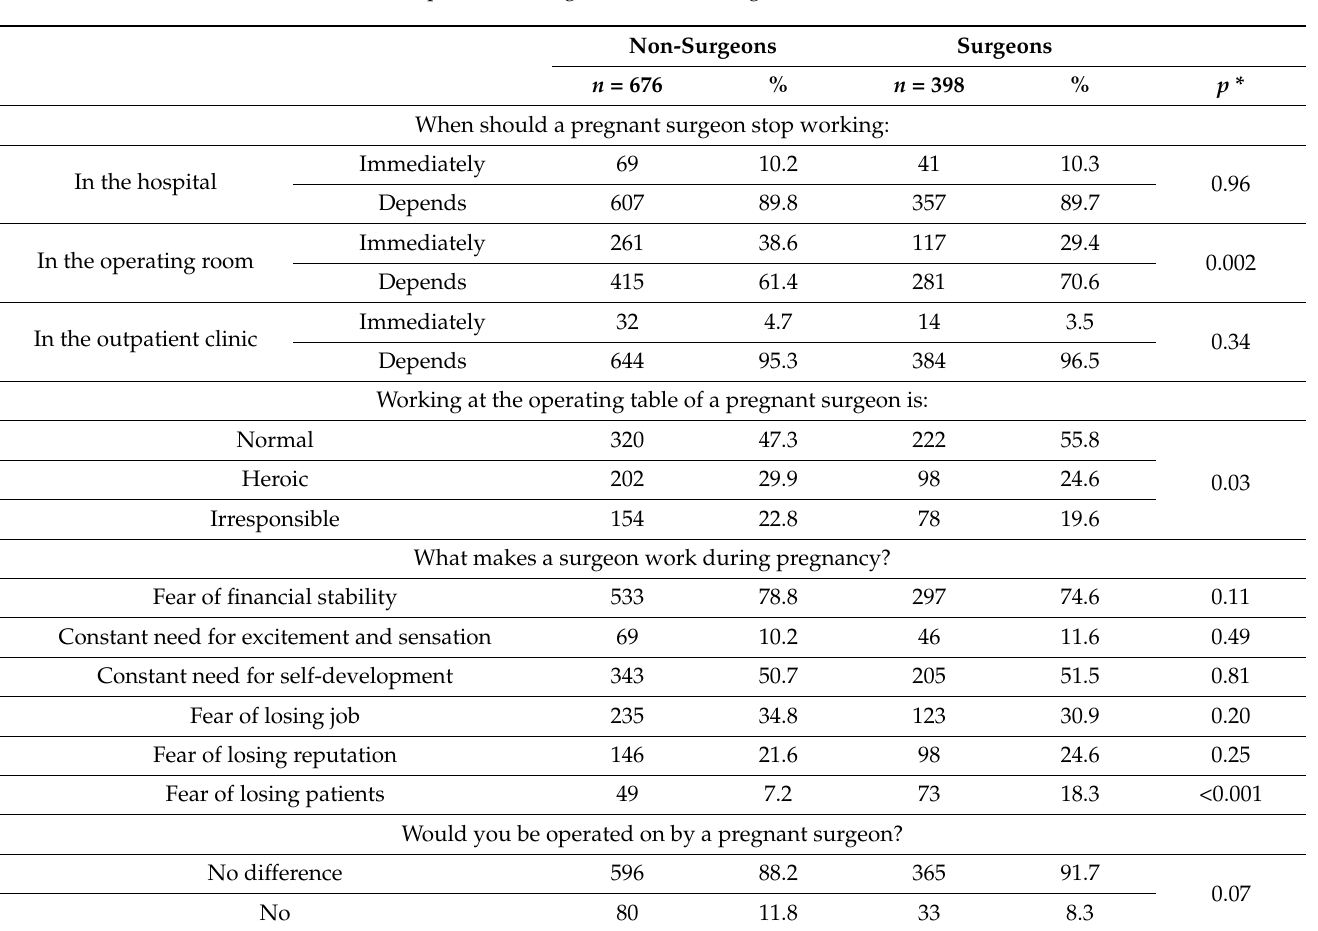
Table 3. Opinions of surgeons and non-surgeons.